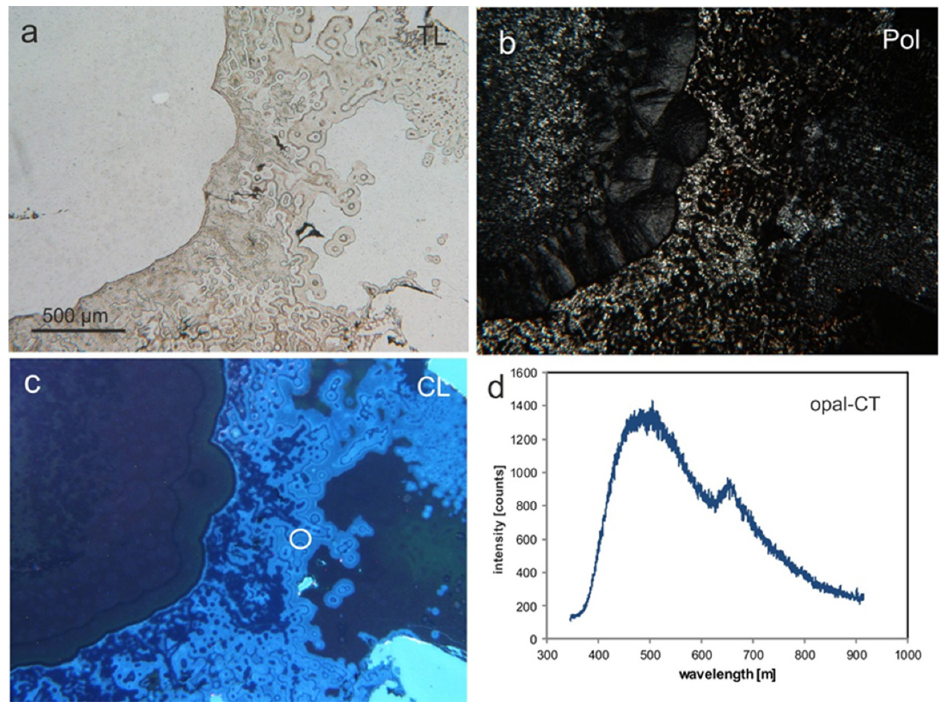
Figure 11. Micrographs of agate ACu3 in transmitted light ( a ) with crossed polars ( b ) and CL mode ( c ) showing the CL of an opal-CT rich area with a bright blue CL. ( d ) The related CL spectrum is dominated by a broad band centered around 500 nm; the circle in ( c ) marks the position of the spectral CL measurement.